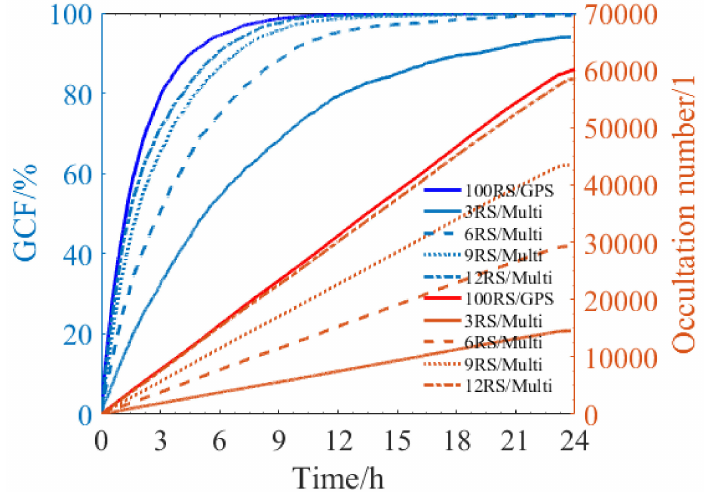
Figure 6. Occultation number and global coverage fraction trend of 100RS/GPS and polar-orbit RS constellation/multi − GNSS RO